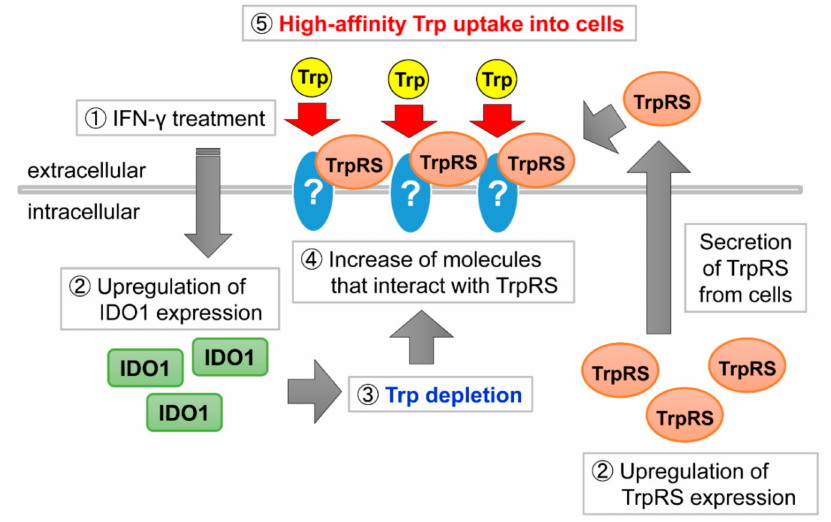
Figure 5. A schematic model of the regulatory mechanism of TrpRS-mediated Trp uptake upon interferon (IFN)- γ treatment of human